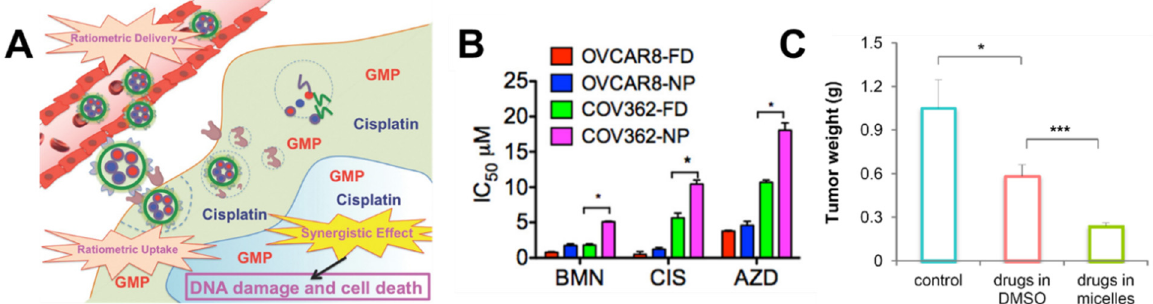
Figure 6. ( A ) Schematic overview of co-delivery of cisplatin and gemcitabine using polymer nanocarriers for synergistic effect (adapted with permission from [30] MDPI Open Access). ( B ) Co-formulation of cisplatin (CIS) and talazoparib (BMN) or olaparib (AZD) in lipid/polymeric nanoparticles (NPs) enhanced potency as indicated by the decrease in IC50 compared to the free drug (FD). * indicate a statistically significant difference between the IC50 of the free drug and nanoparticle formulation. Statistical analysis was performed by one-way ANOVA ( p < 0.05). Reprinted (adapted) from [101] John Wiley & Sons Open Access. ( C ) Paclitaxel and tanespimycin (17-AAG) co-delivered in micelles (green) displayed the greatest suppression in tumor growth as indicated by the statistically significant reduced tumor weight on day 43 compared to the free drug combination (*, p < 0.05; ***, p < 0.0005, n = 6 mice). Reprinted (adapted) with permission from [112] PLoS Open Access.